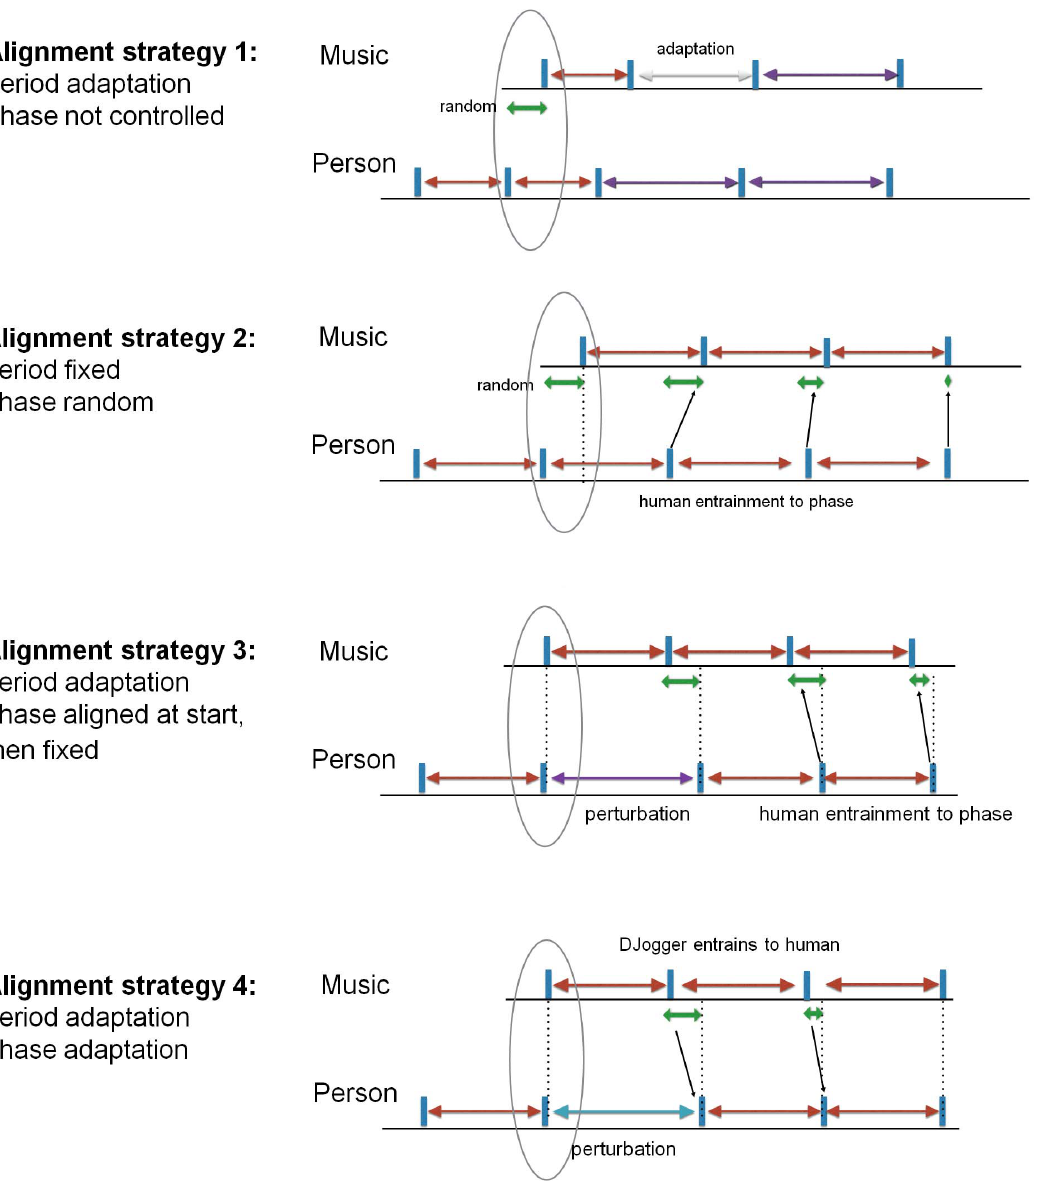
Fig. 4. Four different alignment strategies. 1. The song starts in tempo but not in-phase. During the song, the music period is adapted to the walking period. 2. The song starts in tempo but not in-phase. During the song, the music period is kept fixed. The human entrains to the phase of the song. 3. The song starts in tempo and in phase. During the song the phase is kept fixed, while the music period is adapted to the walking period. The human entrains to the phase of the song. 4. The song starts in tempo and in phase. During the song, the period and phase are adapted. The music player follows human changes in period and